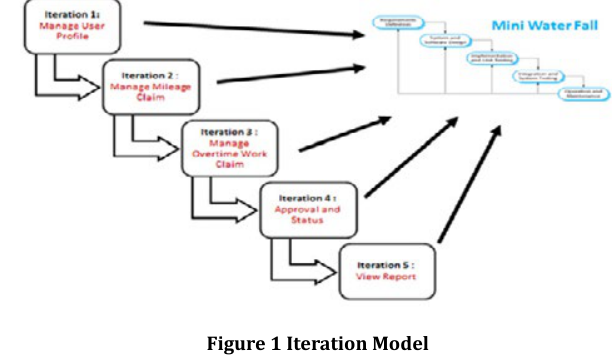
Figure 1 Iteration Model